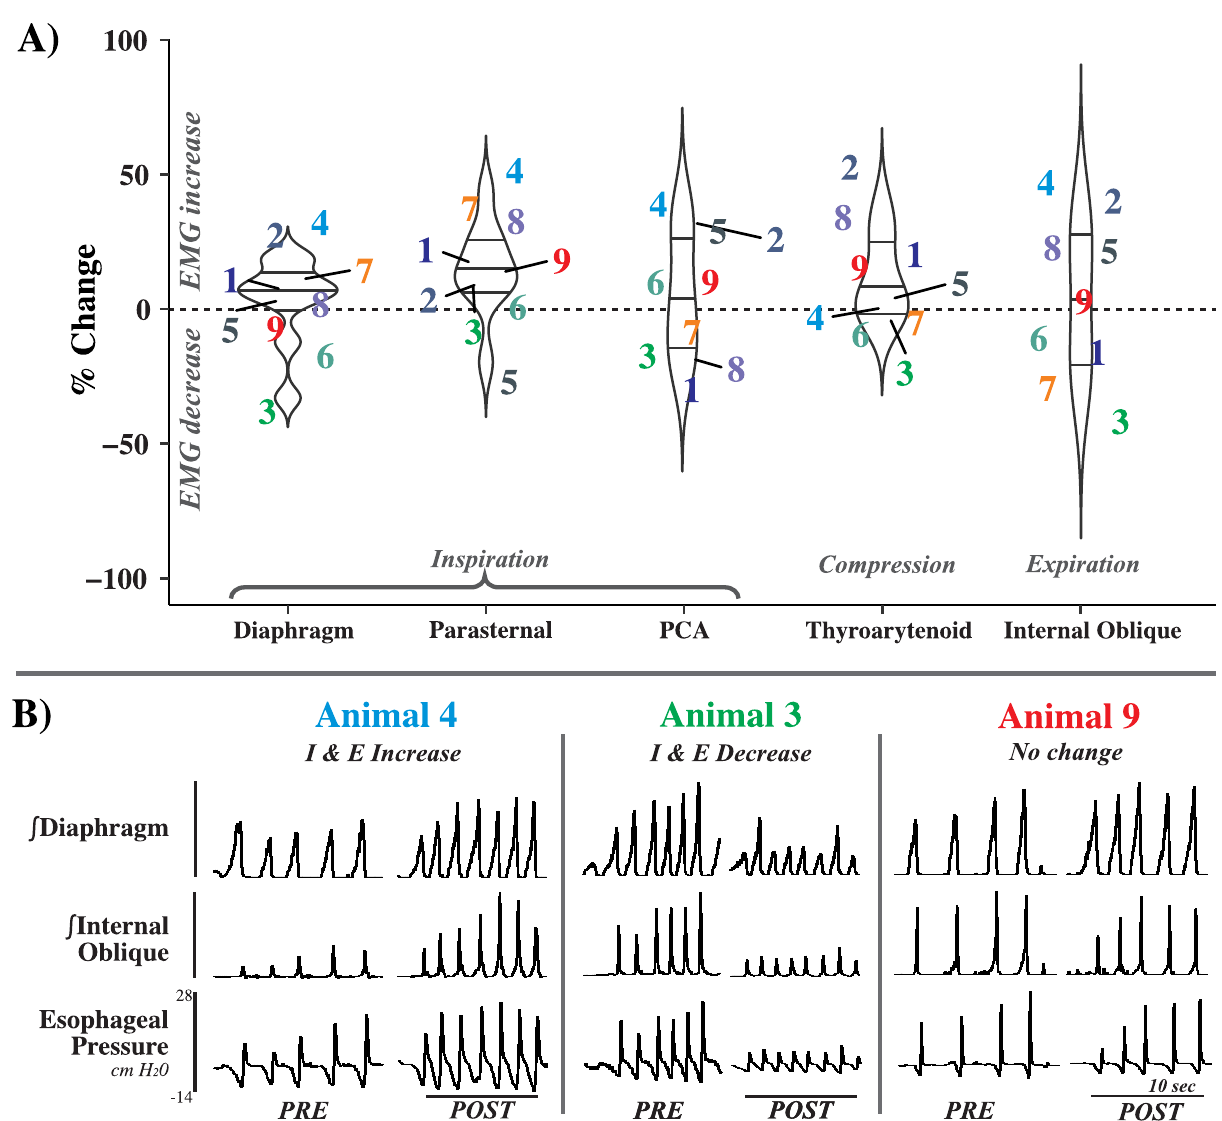
Fig 2. Animal-by-animal effects of cerebellectomy on cough. A) Percent change of maximum EMG amplitude > 1 hour post-cerebellectomy during cough, plotted by animal number for the diaphragm, parasternal, posterior cricoarytenoid (PCA), thyroarytenoid, and internal oblique muscles. Note the spread for each muscle in the increasing and decreasing directions. B) Examples from 4 animals showing disparate responses to cerebellectomy. While there was a trend towards the enhancement of some cough related EMGs, particularly the inspiratory pump muscles (Animals 3 and 4), individual responses were heterogeneous, with some EMGs being suppressed (Animal 3) or not changing at all (Animal 9). n = 9.